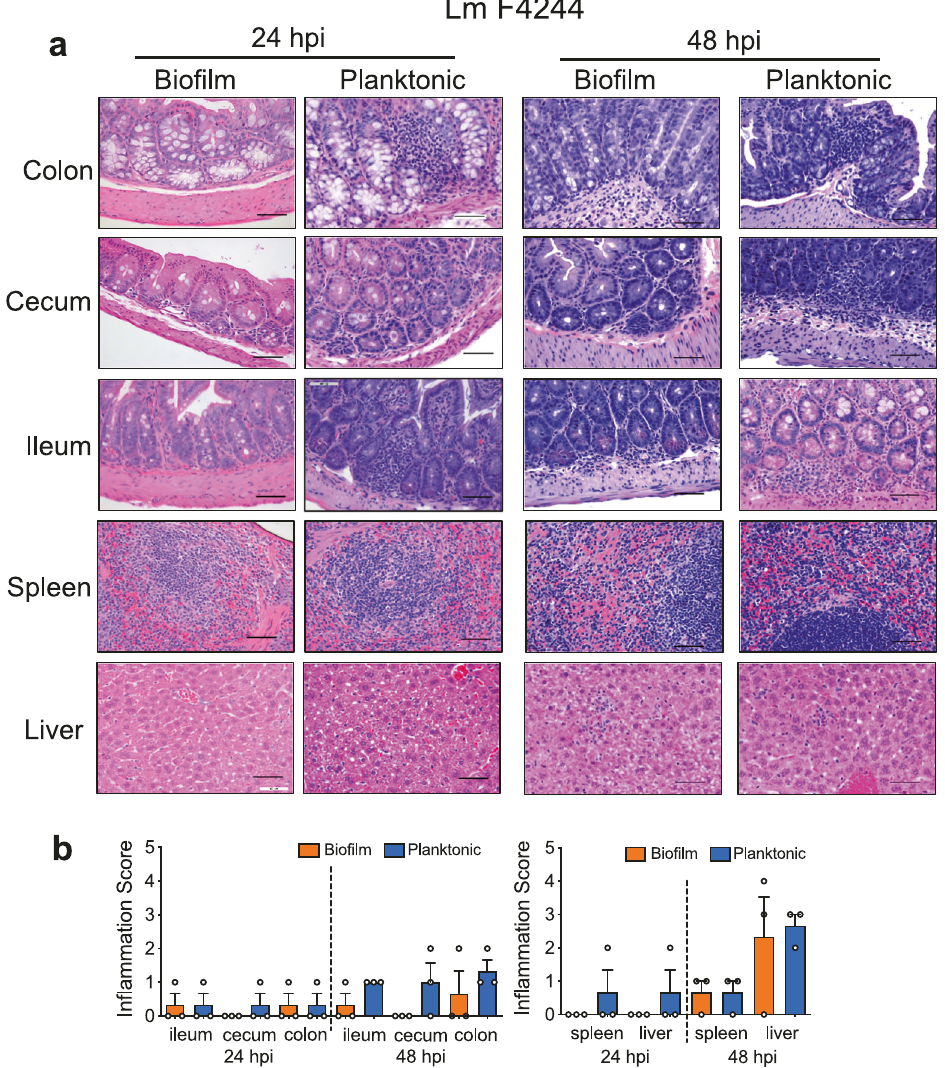
Fig. 6 Histopathology analysis of mouse tissues for in fl ammation. Representative images of hematoxylin and eosin-stained tissue sections of mice challenged with 1 × 10 9 CFU of F4244 sessile (B) or planktonic (P) cells at 24 and 48 hpi ( a ) and a graph representing histopathological in fl ammation scores at 24 hpi ( b , left panel) and 48 hpi ( b , right panel). Scale bars represent 50 μ